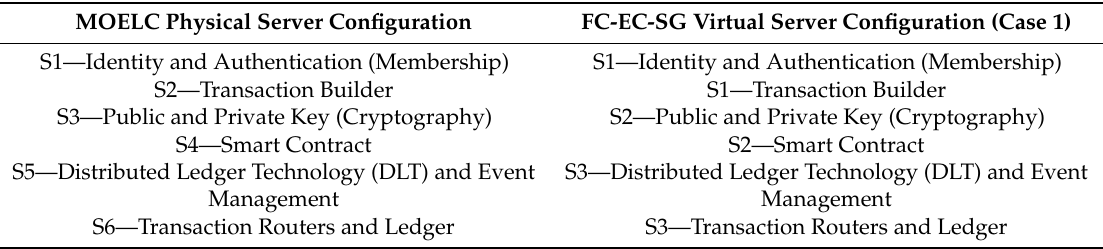
Table 7. Comparison between virtual and physical server configuration for the G A.